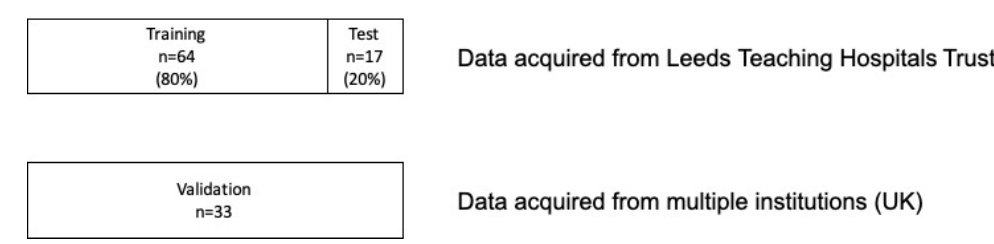
Figure 1. The steps of a radiomic diagnostic model.